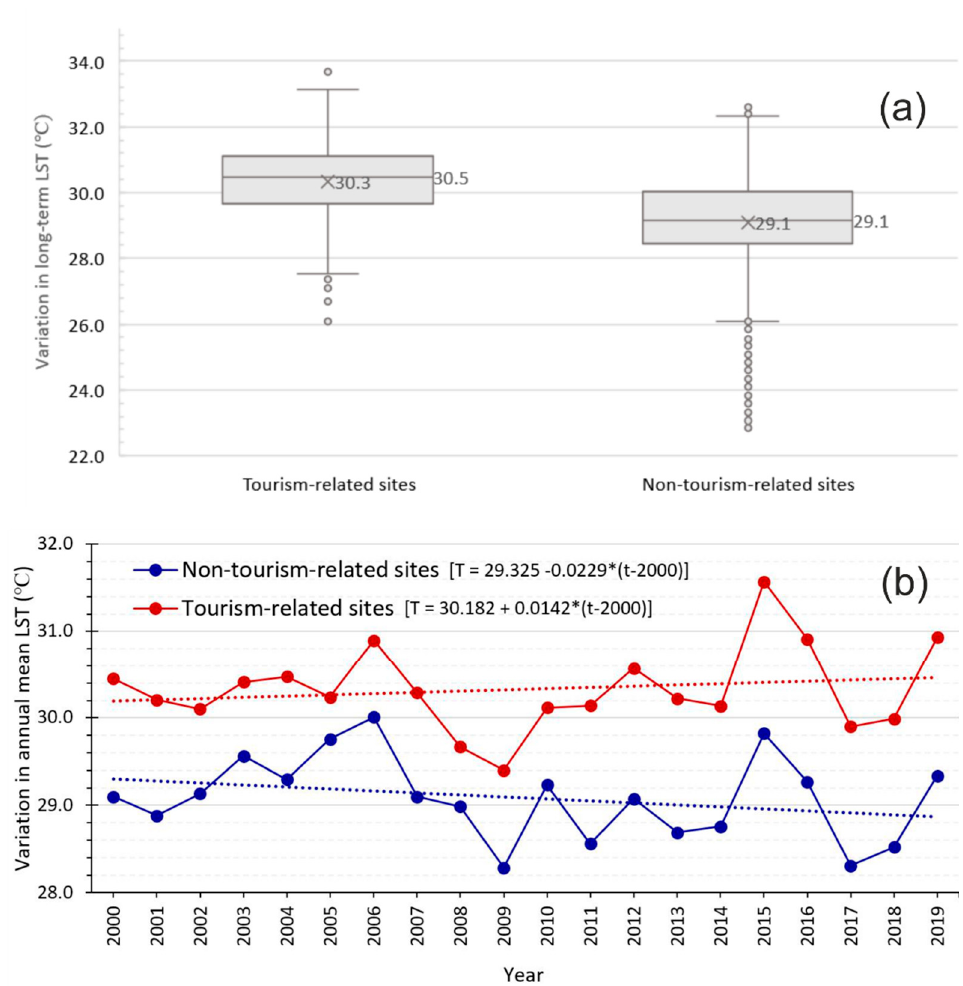
Figure 7. Annual LST variation in tourism-related and in non-tourism-related sites: (7( a ) Box and Whisker plots of long-term (20-year) variation of LST showing relatively high mean (30.3 °C) and median (30.5 °C) LST in tourism-related sites against a mean and median of 29.1 °C in non-tourism related sites. 7( b ) Annual mean LST variation showing positive and negative trends of change in tourism-related sites and in non-tourism related sites, respectively).